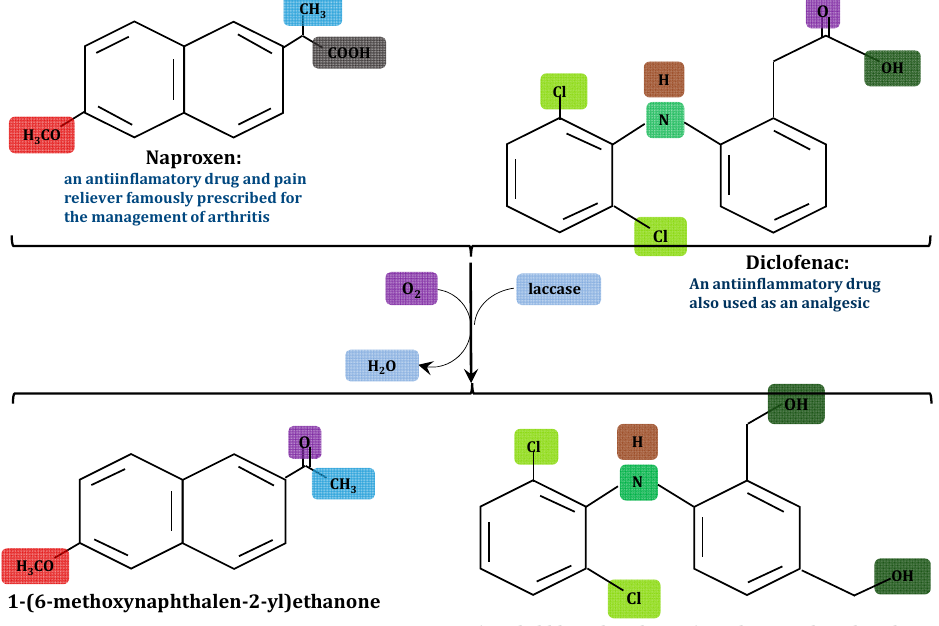
Figure 4. Laccase oxidative transformation of some hospital wastewater pollutants.